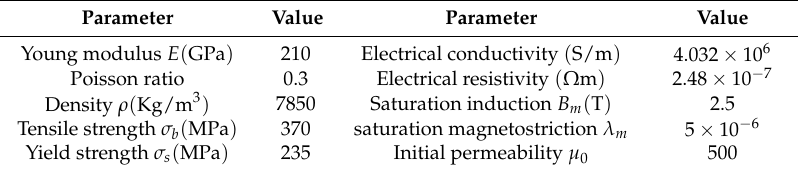
Table 2. Mechanical parameters and magnetic characteristic parameters of simulated strip steel.